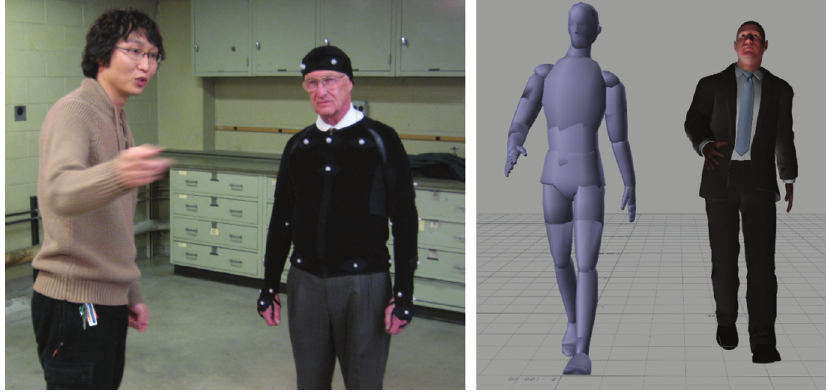
Figure 11. Performance Capture: Dr. Schwarzkopf in Motion-Capture Session (Left) and Motion- Capture Data Retargeting